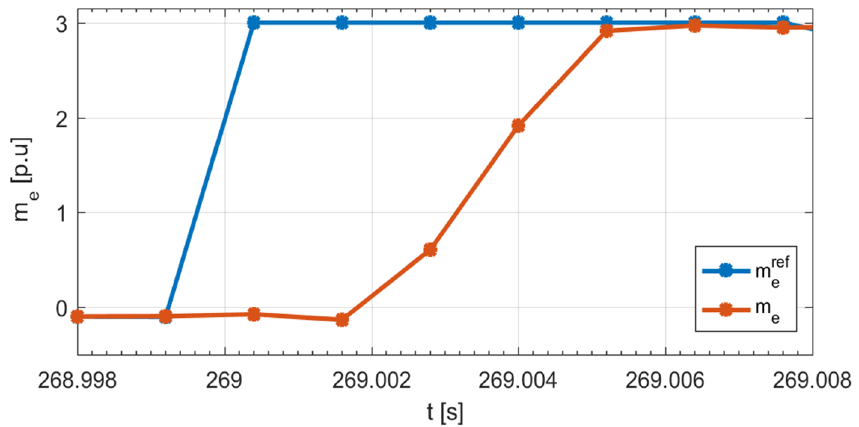
Figure 7. Response delay of the torque control system. Table 3. Comparison of program execution times by the PLC